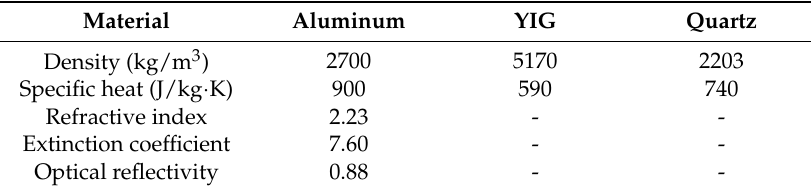
Table 2. Material properties used in the numerical analysis.